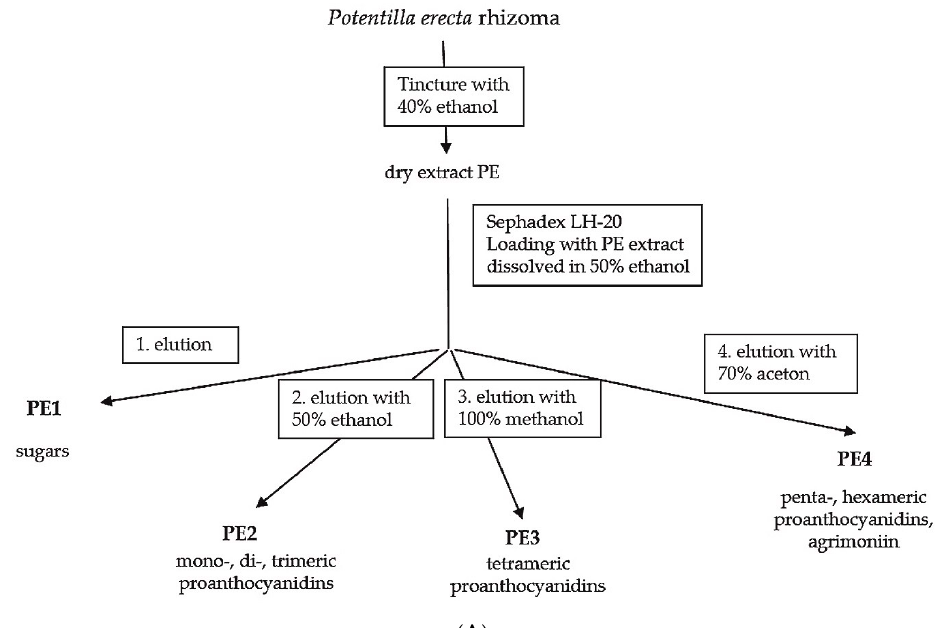
Figure 1. Cont. Figure 1.